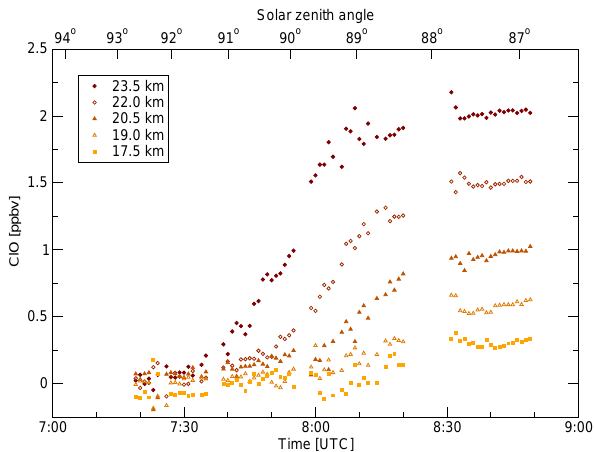
Fig. 11. The ClO concentration as function of time for five different altitudes in the range 17.5–23.5 km . The temporal resolution is 1 minute . The data gaps are due to additional calibration measurements. The onset of the increase in ClO starts first for higher altitudes because the sunrise occurs earlier at these altitudes.